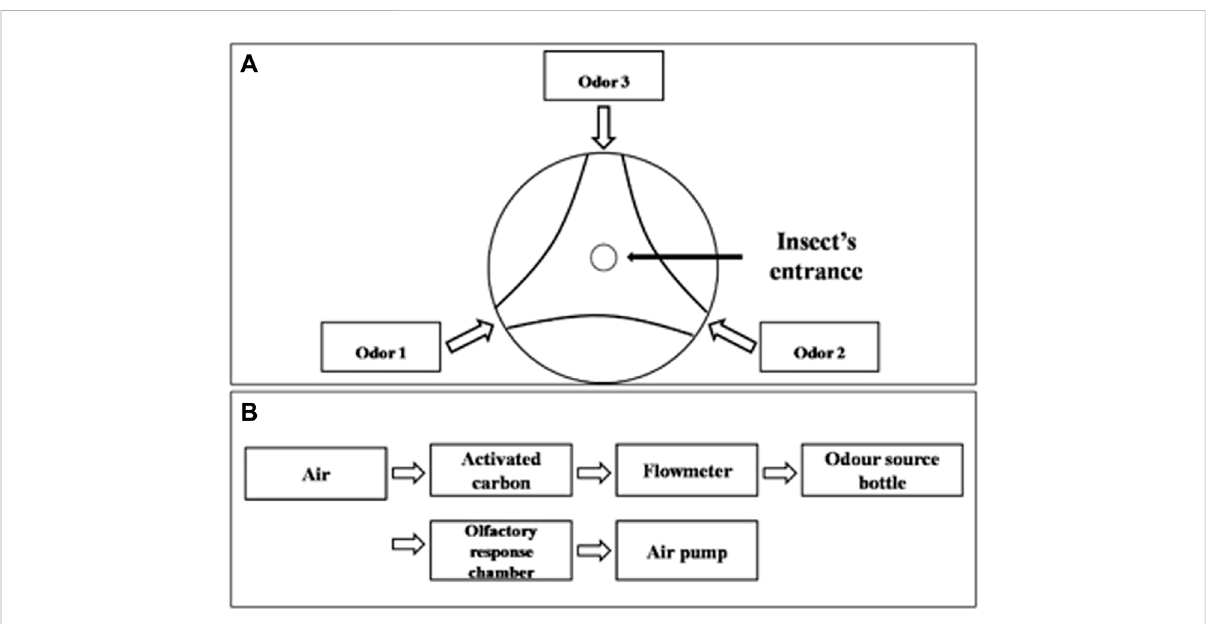
FIGURE 1 Schematic diagram of YMM 3 – 150 olfactometer. (A) Top view of olfactory reaction chamber of olfactometer, (B) connections diagram of